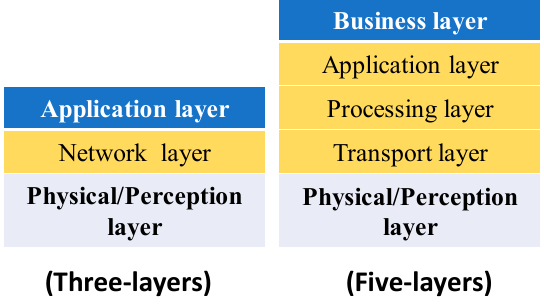
Figure 1. IoT architecture with three and five layers.